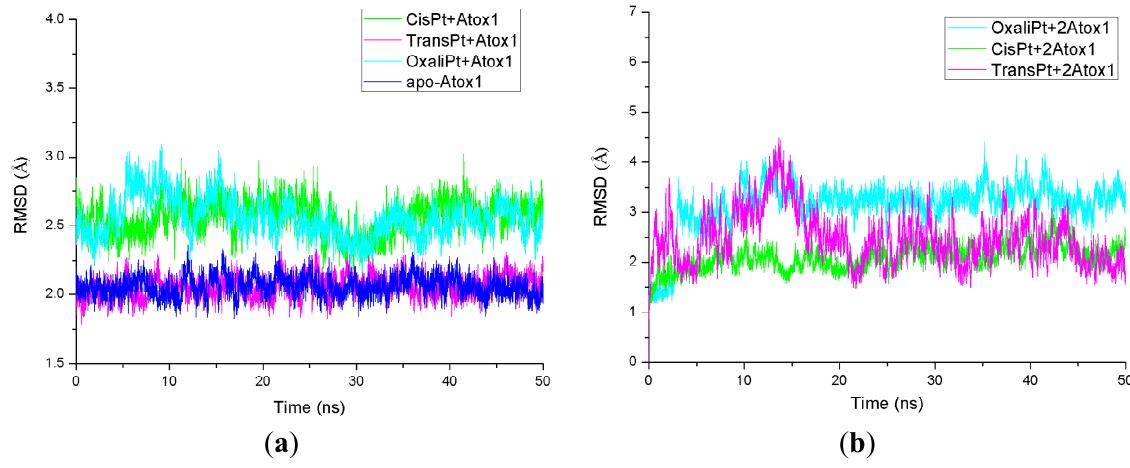
Figure 1. Root-mean-square deviation (RMSD) values of all backbone atoms with respect to the corresponding starting structures for the simulations of ( a ) the apo-Atox1 ( light blue ), CisPt + Atox1 ( green ), TransPt + Atox1 ( magenta ) and OxaliPt + Atox1 ( cyan ) models; and ( b ) the CisPt + 2Atox1 ( green ), TransPt + 2Atox1 ( magenta ) and OxaliPt + 2Atox1 ( cyan )